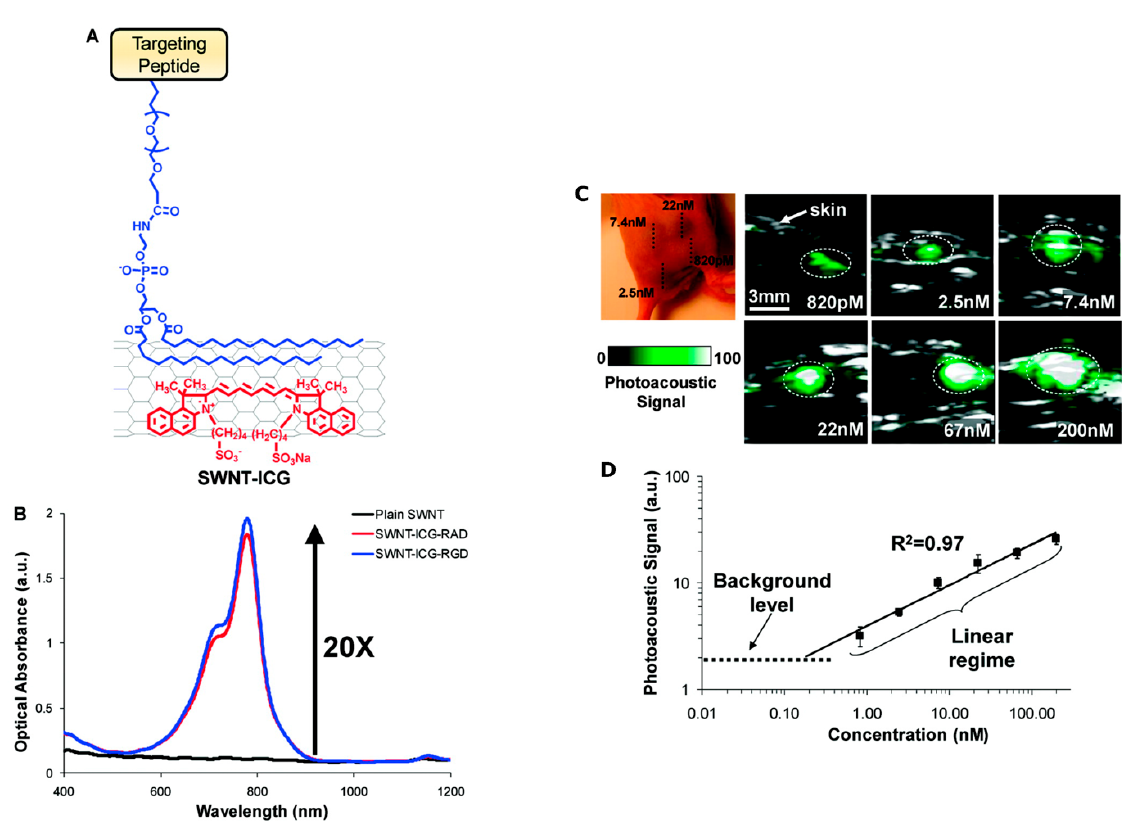
Figure 7. ( A ) Illustration of double CNT functionalization. ( B ) Optical spectra of plain SWNT. ( C ) Photoacoustic (PA) detection of SWNT-ICG in living mice at different concentrations. ( D ) Correlation between the functionalized CNT concentration and the corresponding PA signal. Reprinted with permission from Nano Letters, Copyright 2010, American Chemical Society [43].